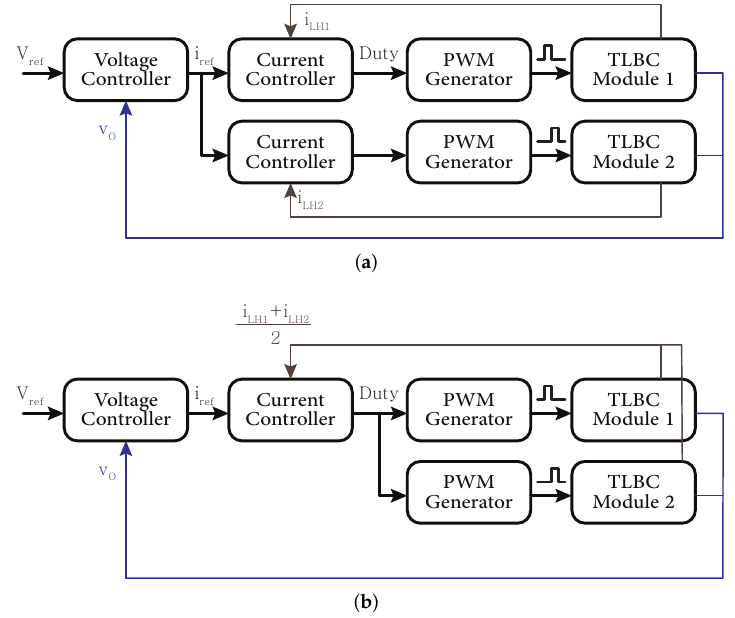
Figure 19. ( a ) TLBC with two current controllers; ( b ) TLBC with single current